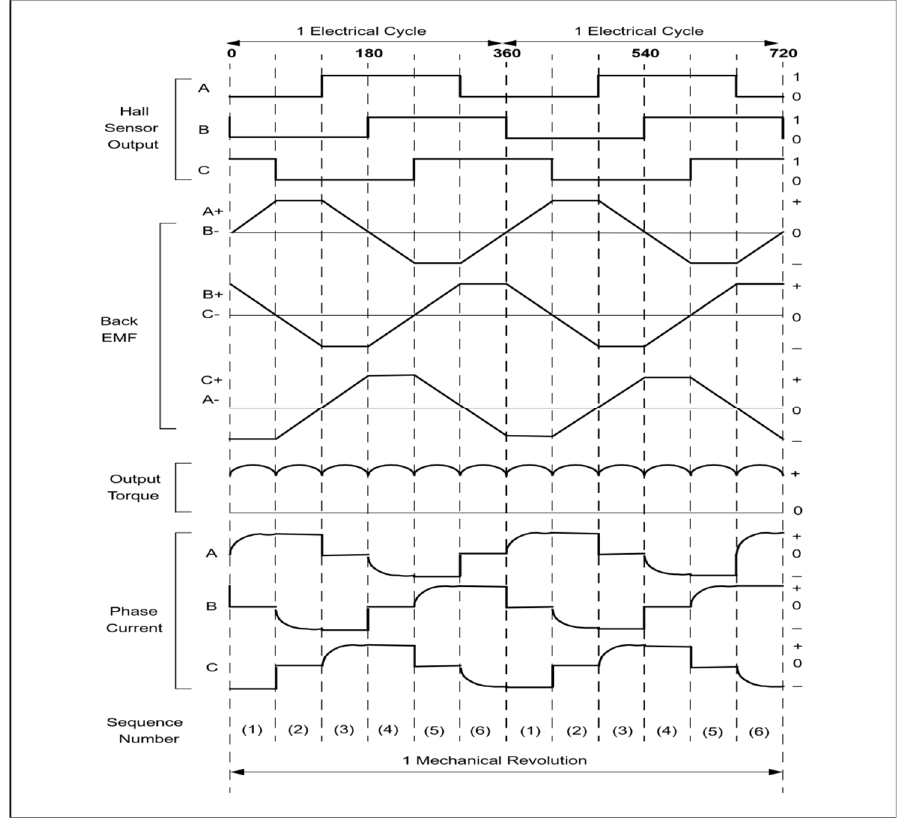
Figure 3. Hall sensor signal, back-emf, output torque and phase current.